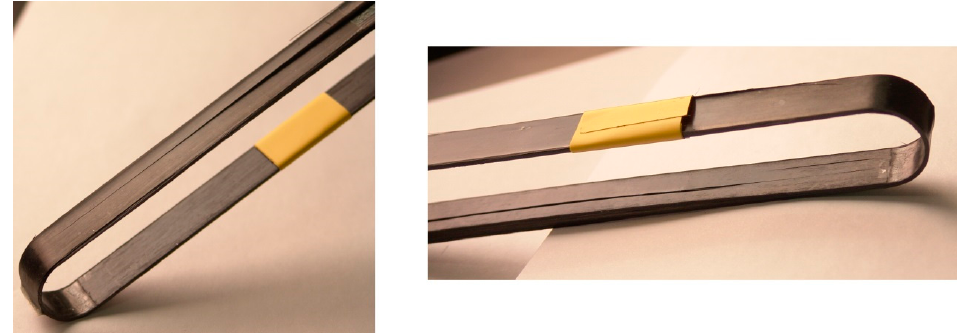
Figure 5. Delamination and longitudinal cracking on a fretting fatigue tested strap. Strap tested for N = 9 × 10 4 cycles at 800 MPa.